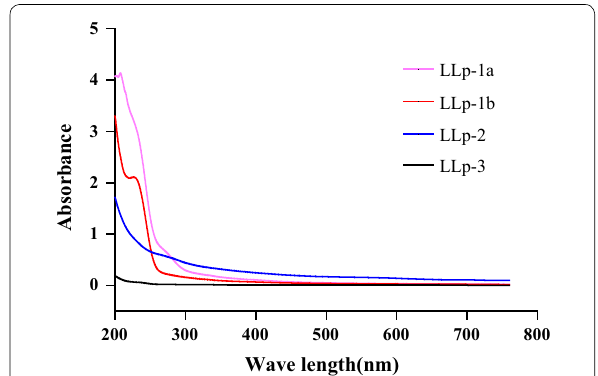
Fig. 2 UV-Vis spectra full-wavelength scanning curves of LLp-1a, LLp-1b, LLp-2 and